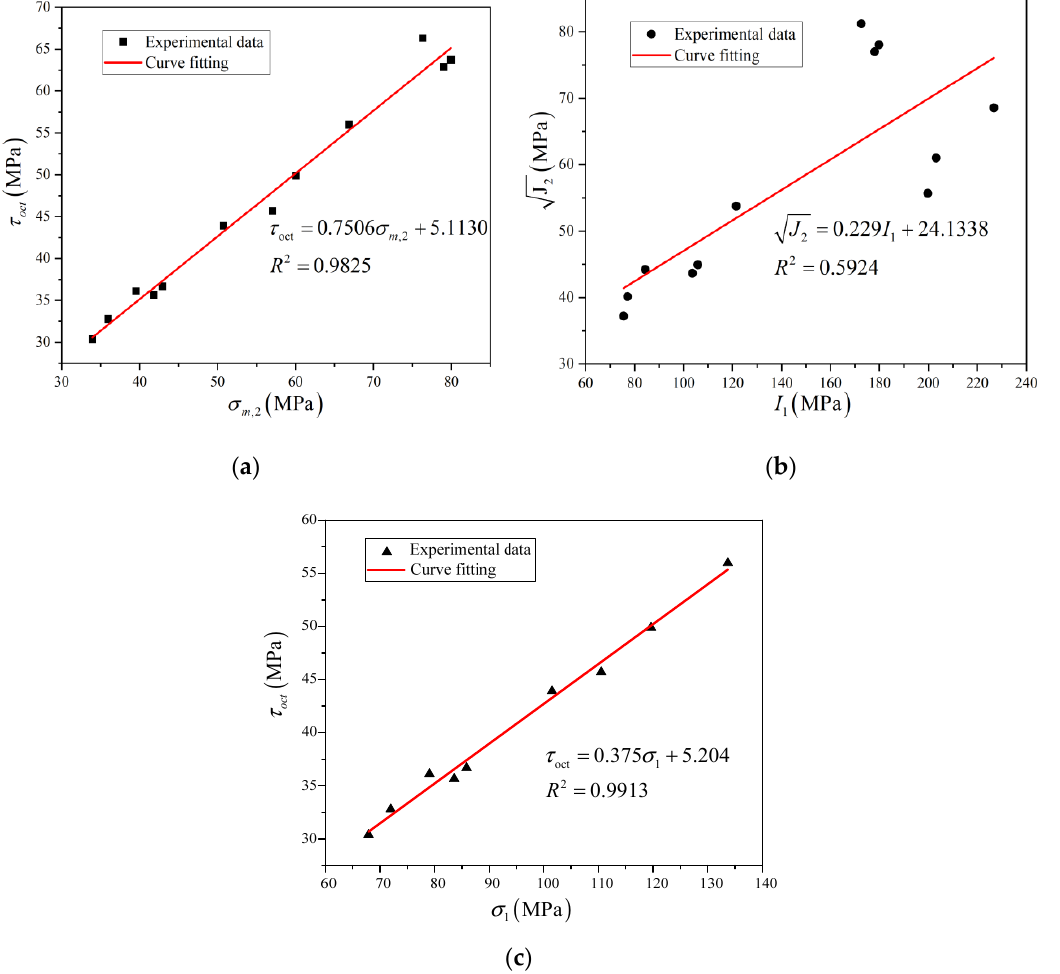
Figure 4. Strength fitting curves of red sandstone failure under different stress paths. ( a ) Mogi– Coulomb; ( b ) Drucker–Prager; ( c ) New strength criterion.